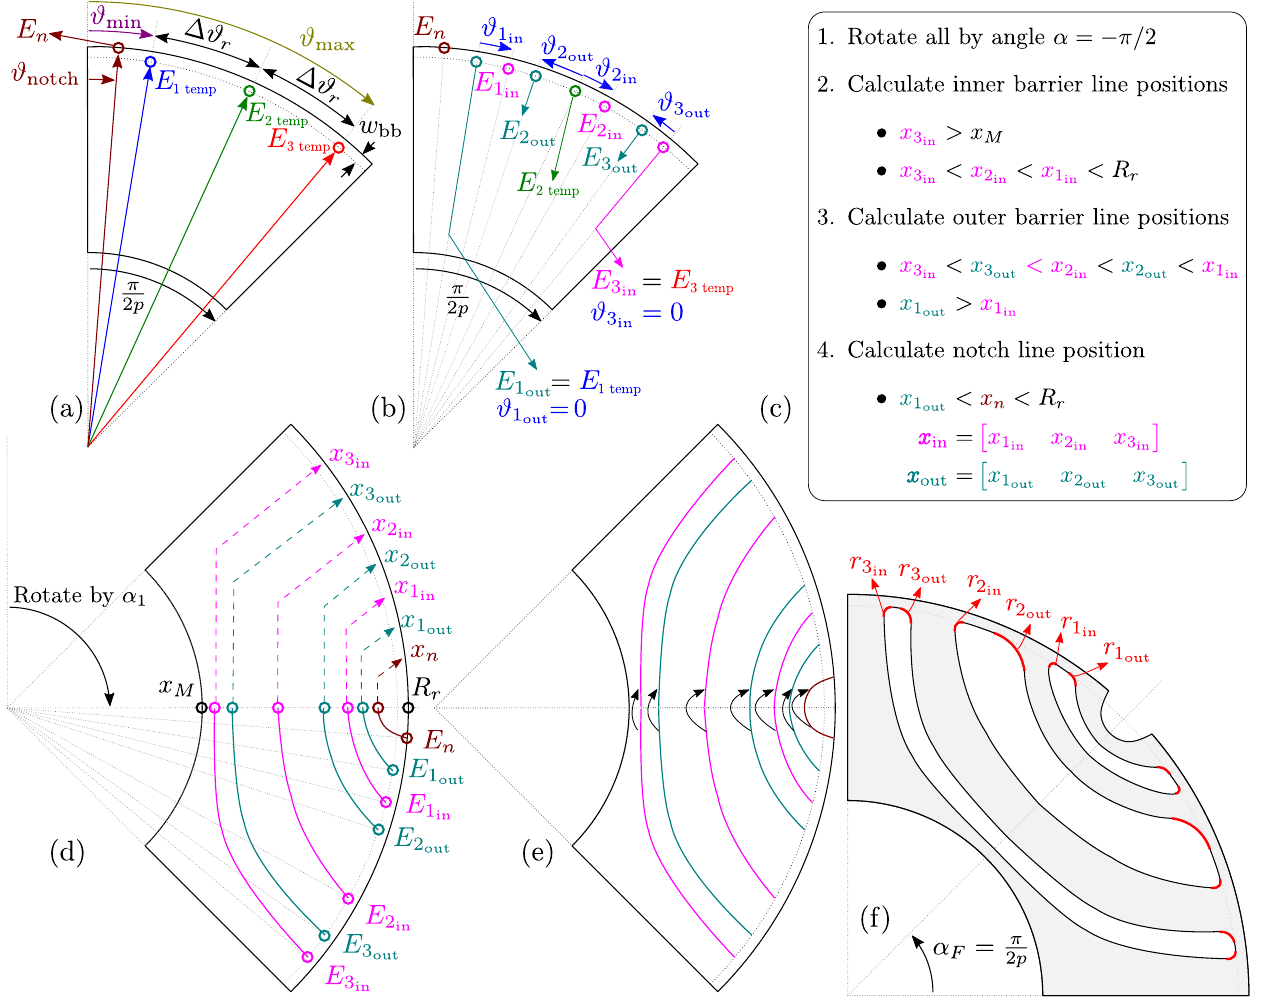
Figure 4. Rotor barrier construction procedure. Initial rotor construction step ( a ); Construction of inner and outer barrier line starting points ( b ); calculation of barrier intersection points ( c ); calculation of barrier vertices ( d ); vertex mirroring ( e ); rotation around center and addition of barrier fillets ( f ). The second step (Figure 4b) is the construction of inner and outer barrier line starting points ( E in , E out ). The points are calculated relative to E 1..k temp , based on additional set of dimensionless parameters ϑ 1..k in , ϑ 1..k out ∈ [ 0, 1 ] (Table 1, 6–11). The third step is rotation around the center point by the specified angle (in this case α 1 = − π /2). Barrier line starting points E in , E out , E n (and additional depth parameters D in , D out , D n depending of the barrier type) are forwarded to the selected construction function which calculates barrier line intersection points ( x in , x out ). The intersection points are calculated based on depth parameters and feasibility conditions listed in Figure 4c. The function returns all inner and outer barrier line vertices ( X in , Y in , X out , Y out , X n , Y n ), Figure 4d. The next step is mirroring line vertices around the horizontal axis (Figure 4e). The final step is the rotation around the center point by the angle α F = π / ( 2 p ) . Barrier ∈ [ 0, 1 ] , Table 1, 12–17) responsible for securing mechanical fillets ( r 1.. k , r 1.. k out in